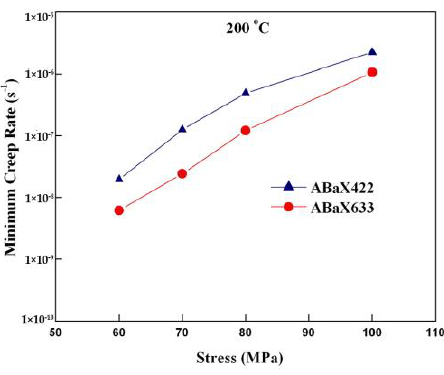
Figure 2. Creep rates at 200 °C under different compressive stresses for ABaX633 and ABaX422 alloys.